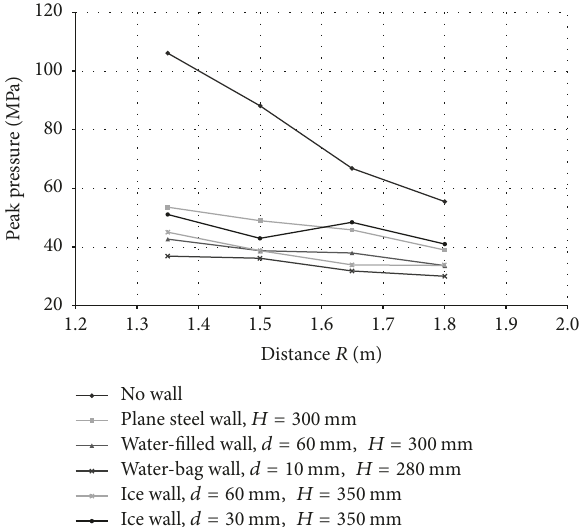
Figure 13: Peak pressure and impulse variation with blast wall fabricated from different